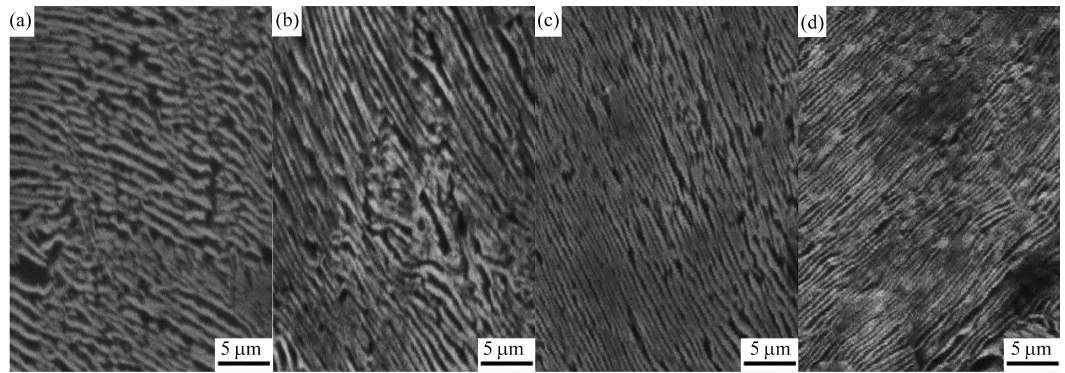
Figure 4: SEM micrographs showing the lamellar pearlite of the samples at different cooling rates: (a) 0.5°C/s, (b) 1°C/s, (c) 3°C/s and (d)